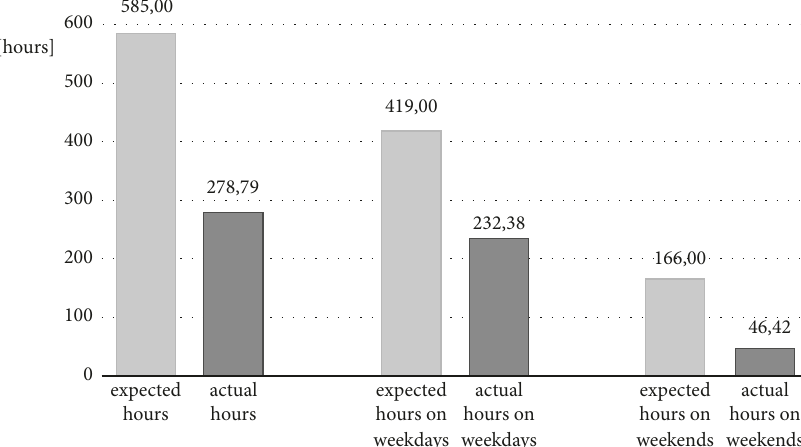
Figure 7: Descriptive analysis of expected and actual hours worn in relation to all days, weekdays, and the weekends for DAFOs.